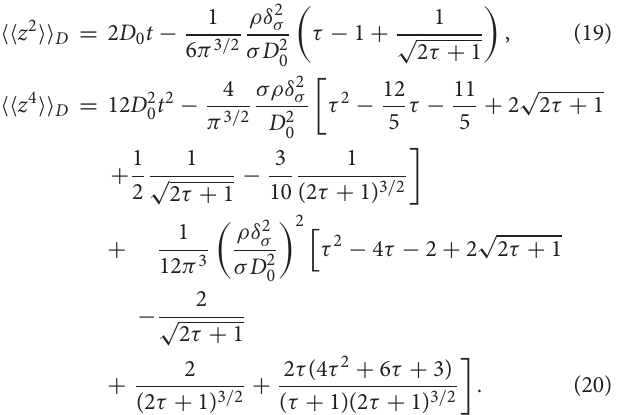
r 2 (solid hh ii D 5, D 0 2 (i.e., ρ 1 /δ σ ), = = = (0) r 2 D , and hh ii ( ) r 2 ∞ D . Results from numerical hh ii (0) 2 r 2 . The D − hh r ii D hh ii